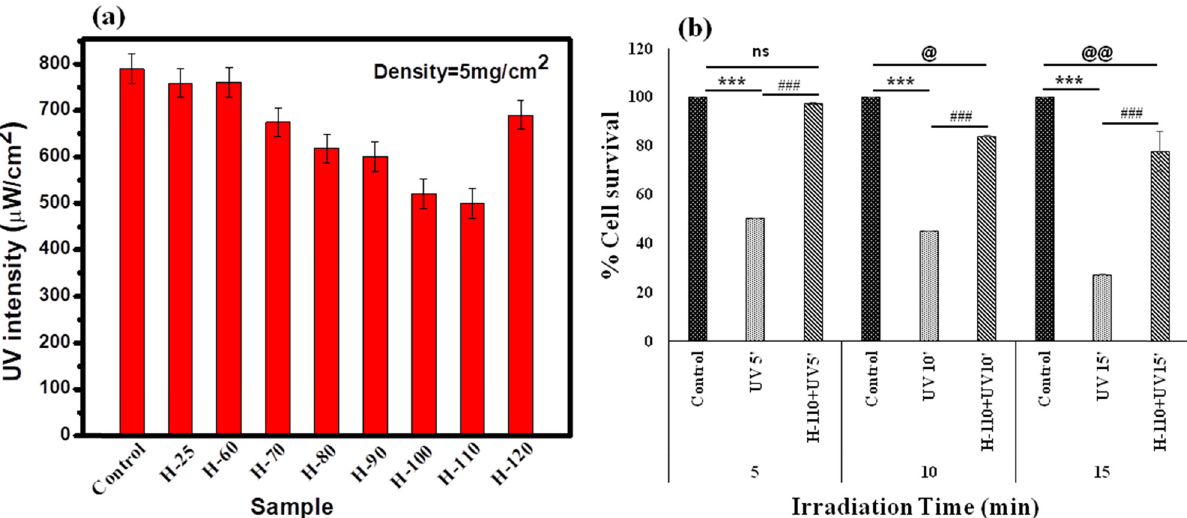
Figure 8: ( a ) UVB attenuation using di ff erent phases of BSA hydrogels, ( b ) protective role of H - 110 from UVB - induced cytological damage primary skin cell culture by % cell viability assay, time - dependent experimental settings ( 5 – 15min ) . Vertical bars representing mean ± SEM. Signi fi cance was tested using one - way ANOVA followed by Tukey Post - hoc test. The symbol * shows the signi fi cance level between control and only UVB, # shows the signi fi cance level between only UVB and H - 110 + UVB, and @ shows the signi fi cance level between only control and H - 110 + UVB. Data